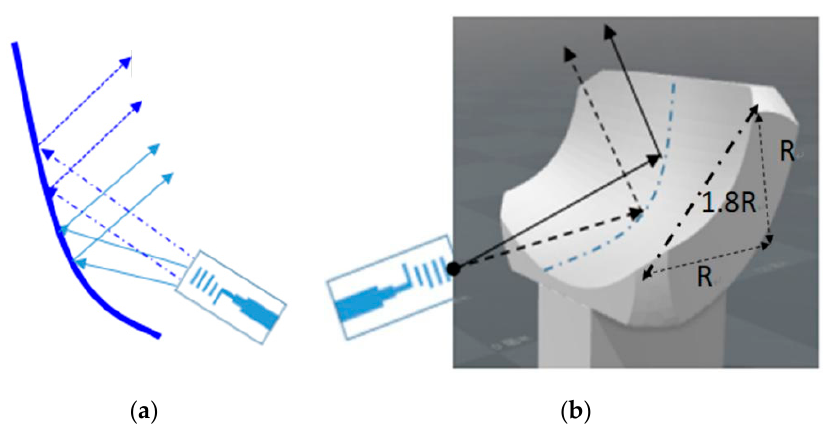
Figure 8. Rays on the longitudinal parabola ( a ) 2D diagram ( b ) 3D diagram.